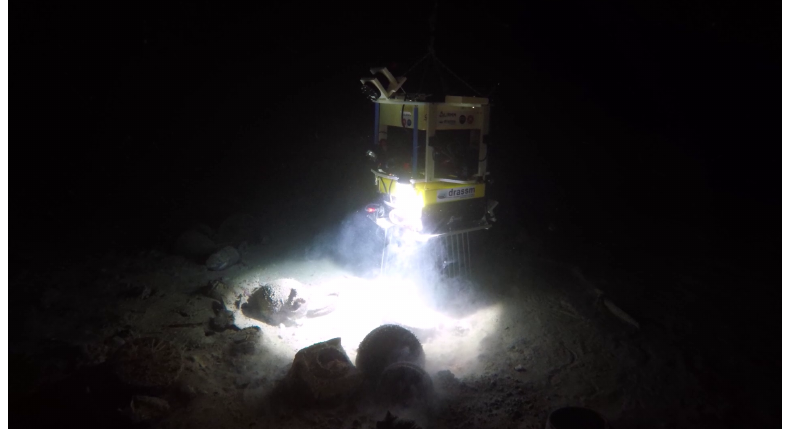
Figure 1. Remotely Operated Vehicle Dumbo performing archaeological sampling on an